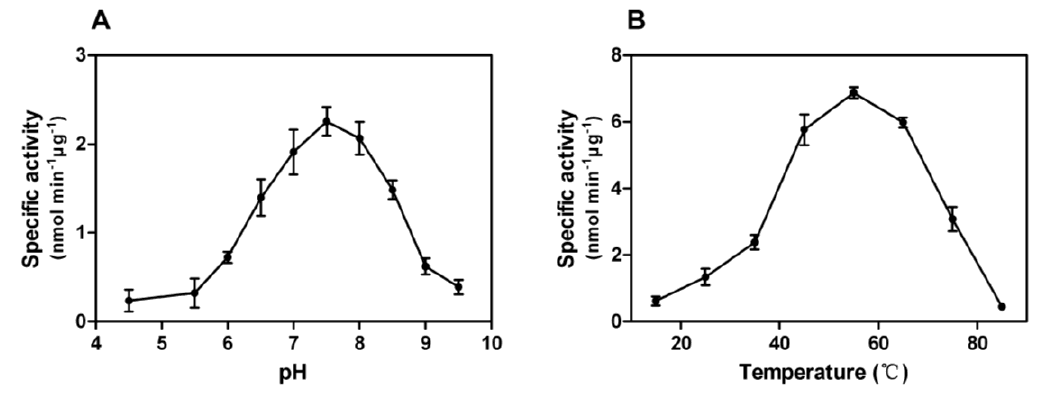
Figure 5. ( A ) Optimum reaction pH; and ( B ) optimum reaction temperature determination of rEcPP5. Each point is the mean ± SD of three independent